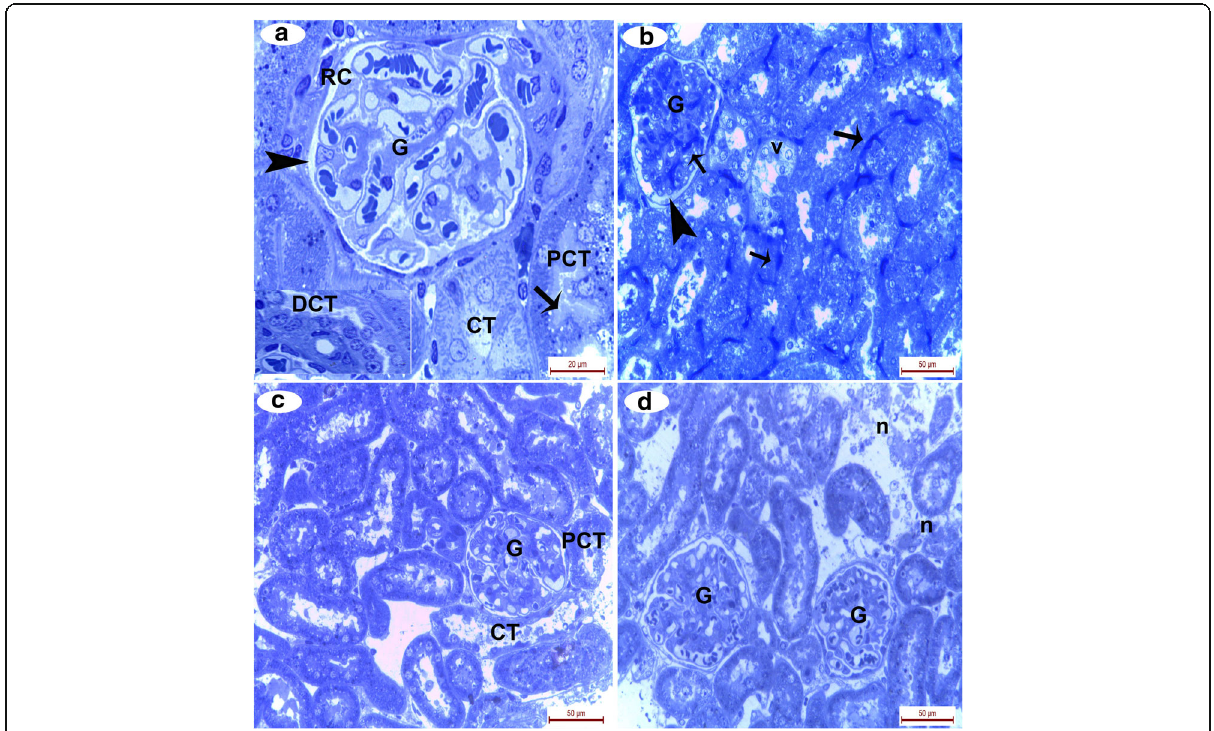
Fig. 1 Photomicrographs of renal cortex of rat. a Control group showing normal architecture of cortical parenchyma, renal corpuscle (RC), glomerulus (G), Bowman ’ s space (arrow head), proximal convoluted tubule (PCT), brush border (arrow), and distal convoluted tubule (DCT) (inserted photo; scale bar=20 μ m). b KT group showing congested blood capillaries inside the glomeruli and in between the renal tubules (arrows), Bowman ’ s space filled with casts (arrow head), hypertrophic glomerulus (G), and vacuolated and degenerated tubular cells (V) (scale bar=50 μ m). c WR group showing focal degeneration in PCT and CT and hypertrophic glomerulus (G) (scale bar=50 μ m). d KT/WR group showing focal necrosis (n) and hypertrophic glomerulus (G) surrounded by narrow Bowman ’ s space (scale bar=50 μ m). Semi-thin sections, toluidine blue